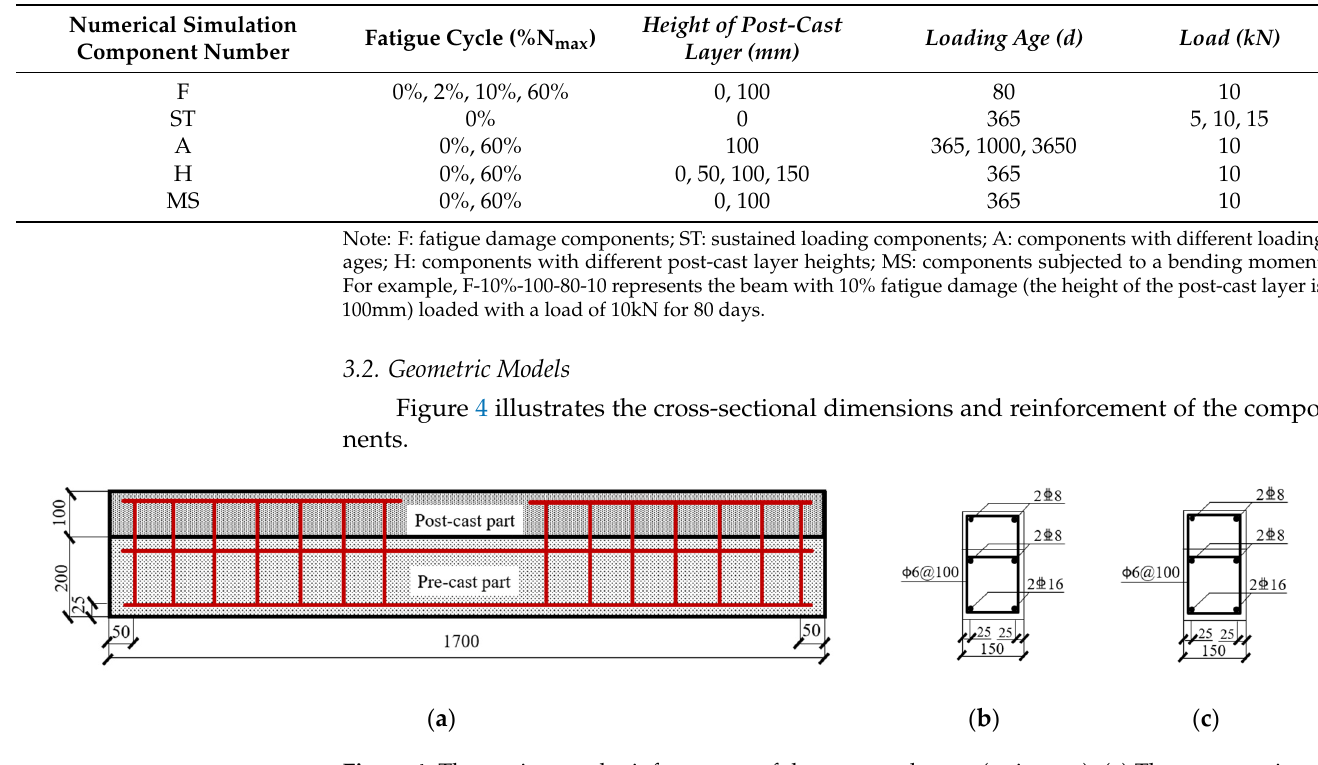
Figure 4. The sections and reinforcement of the concrete beams (unit: mm): ( a ) The cross-sectional dimensions; ( b ) the positive bending moment section; and ( c ) the negative bending moment section.